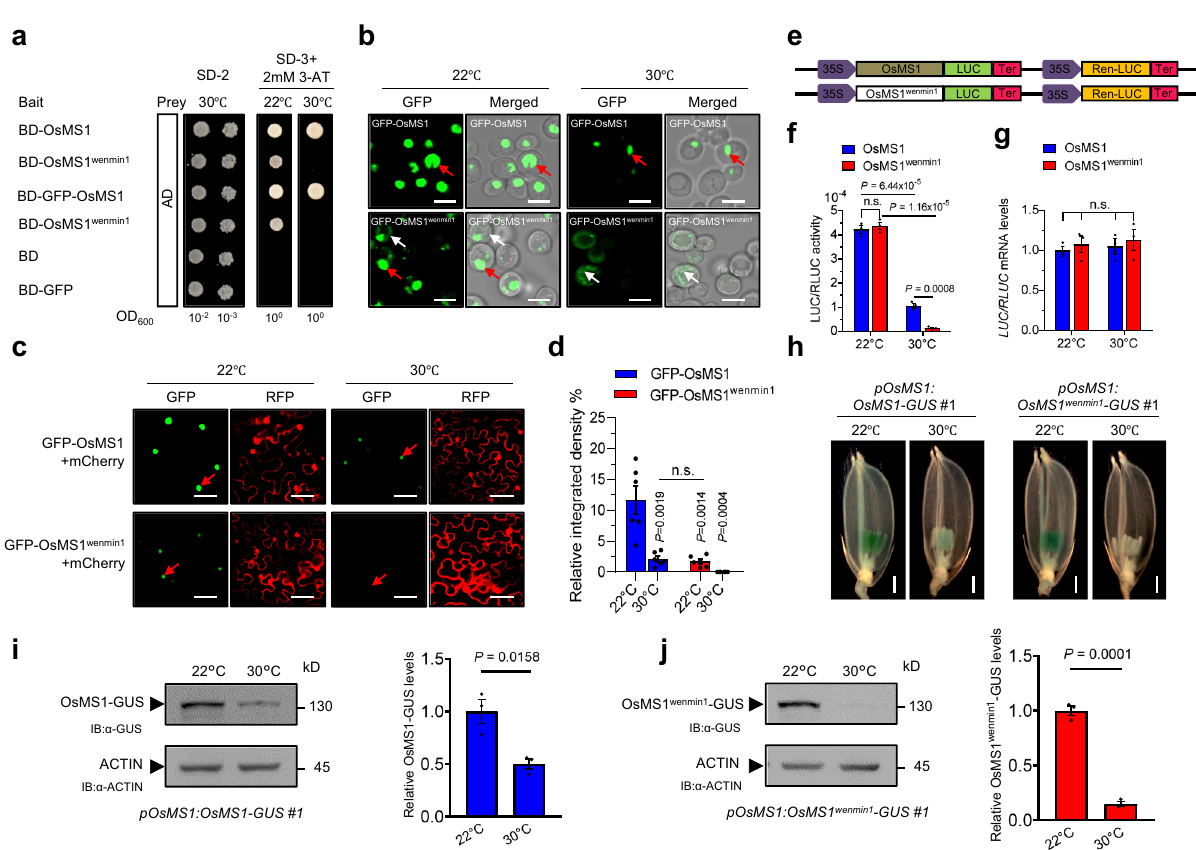
Fig. 3 Temperature regulates the abundances of OsMS1 and OsMS1 wenmin1 . a Transcriptional activation assay in yeast. Yeast cells were spotted on the indicated plates and grown at low (22 °C) or high (30 °C) temperatures for 96 h. BD, binding domain; AD, activation domain; SD-2, plates lacking Trp and Leu; SD-3 + 2 mM 3-AT, plates lacking Trp, Leu, and His, plus 2 mM 3-aminotriazole. b , c Protein levels of GFP-OsMS1 and GFP-OsMS1 wenmin1 are temperature-dependent in yeast cells ( b ) and N. benthamiana ( c ). N. benthamiana were incubated at 22 °C for 44 h and then transferred to the indicated temperatures for another 4 h before detecting the GFP signals. Red arrows indicate nuclei, white arrows indicate cytoplasm. d Quantitative analysis of ( c ). The GFP-OsMS1 and GFP-OsMS1 wenmin1 protein levels were quantitated and normalized to the mCherry level. P values indicate the signi fi cant differences relative to GFP-OsMS1 at 22 °C. e Dual-luciferase system. LUC, fi re fl y luciferase. Ren-LUC, Renilla luciferase. f Relative luciferase activity of OsMS1-LUC and OsMS1 wenmin1 -LUC in N. benthamiana plants during the low temperature to high-temperature transition. g OsMS1 and OsMS1 wenmin1 mRNA levels as in ( f ). h – j Protein levels of OsMS1-GUS and OsMS1 wenmin1 -GUS are temperature-dependent in rice. pOsMS1:OsMS1-GUS and pOsMS1:OsMS1 wenmin1 -GUS transgenic plants were grown at 22 °C or 30 °C in growth chamber. Protein levels of OsMS1-GUS and OsMS1 wenmin1 -GUS were detected by GUS-staining of transgenic plant spikelets at stage 9 ( h ). OsMS1-GUS ( i , left) and OsMS1 wenmin1 -GUS ( j , left) proteins were detected by ani-GUS antibody. Quanti fi cations of OsMS1-GUS ( i , right) and OsMS1 wenmin1 -GUS ( j , right) protein levels were relative to ACTIN. Scale bars, 5 μ m ( b ), 50 μ m ( c ), 1 mm ( h ). In d , f, g , i (right) and j (right). Data are presented as means± s.e.m. ( n = 6 biological replicates for d , n = 3 biological replicates for f , g , i , and j ). Two-tailed unpaired t -test was used for statistical analysis. n.s., not signi fi cant. Source data are provided as a Source data fi